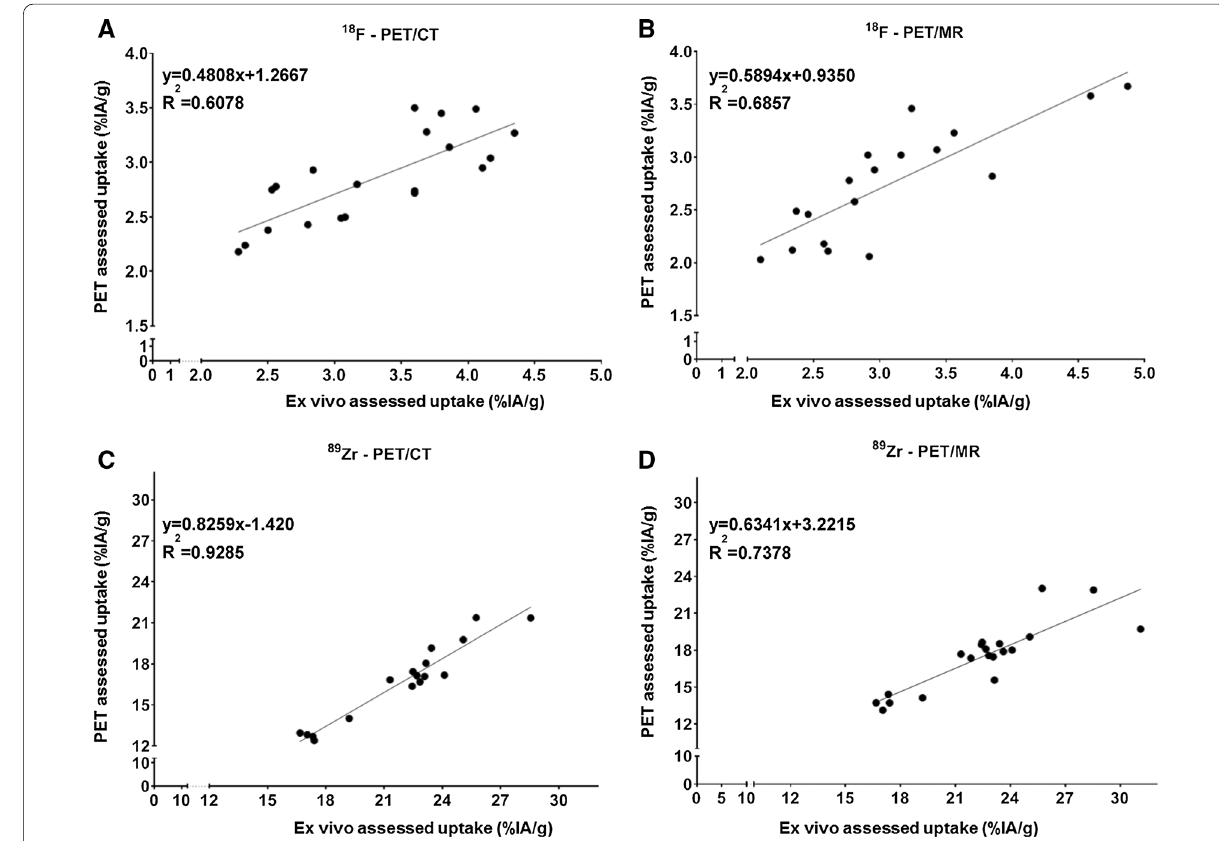
Fig. 4 Linear regression plots showing the correlation between tumor uptake assessed by PET imaging (PET/CT: A , C ; PET/MR: B , D ) and ex vivo biodistribution for [ 18 F]FDG ( A , B ) and [ 89 Zr]Zr-DFO-NCS-trastuzumab ( C , D )